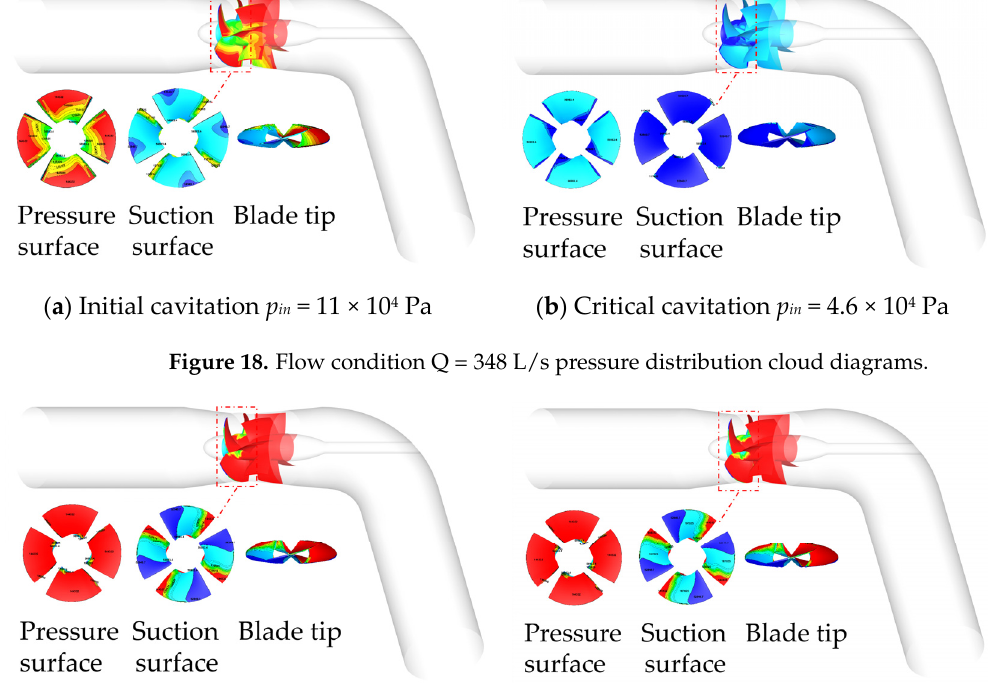
Figure 17. Flow condition Q = 380 L/s pressure distribution cloud diagrams.